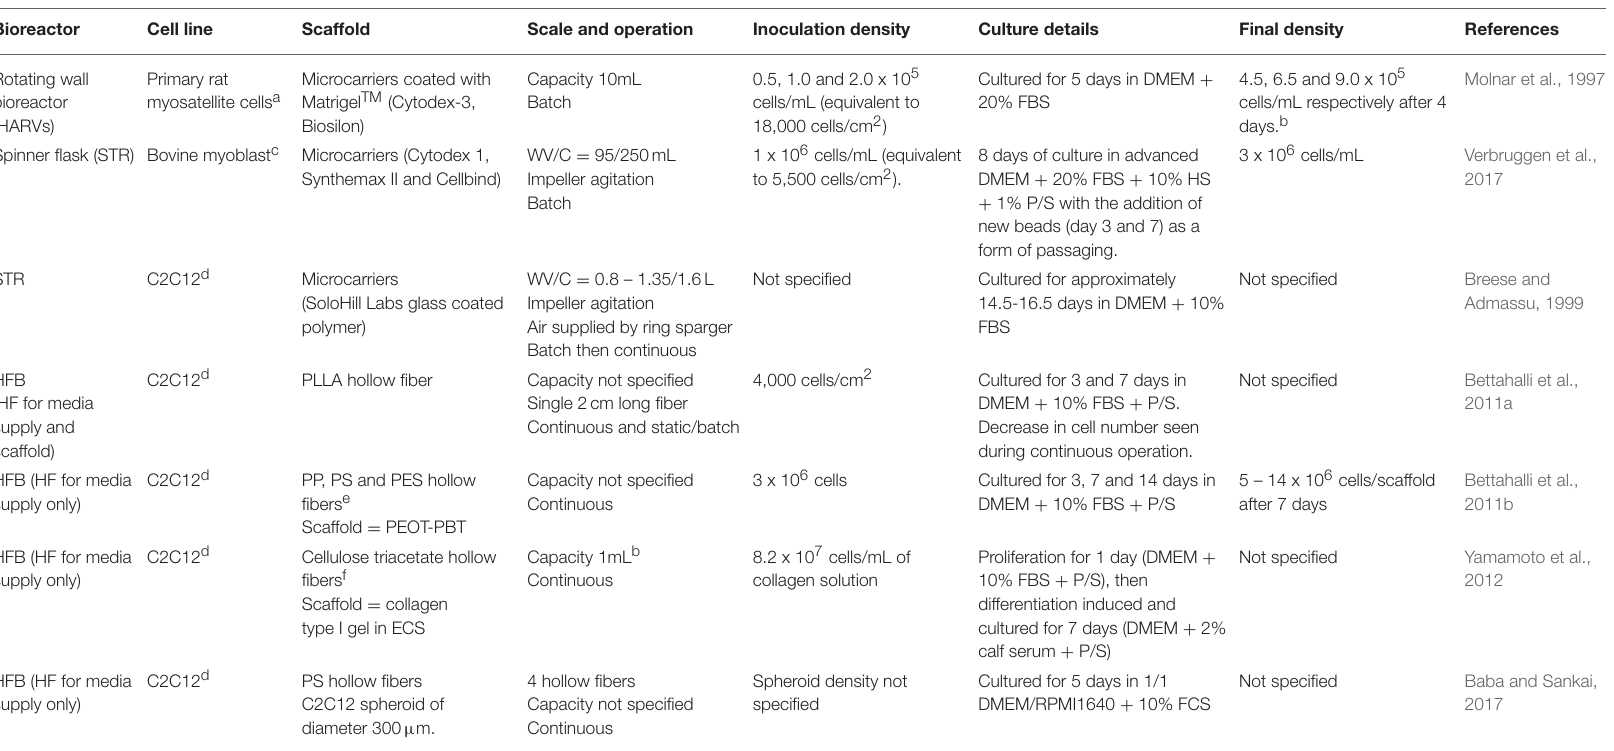
TABLE 1 | Bioreactors that have been used for the expansion of skeletal muscle